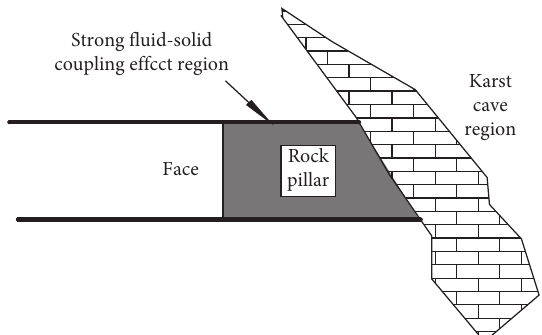
Figure 2: The schematic diagram for a water-proof rock